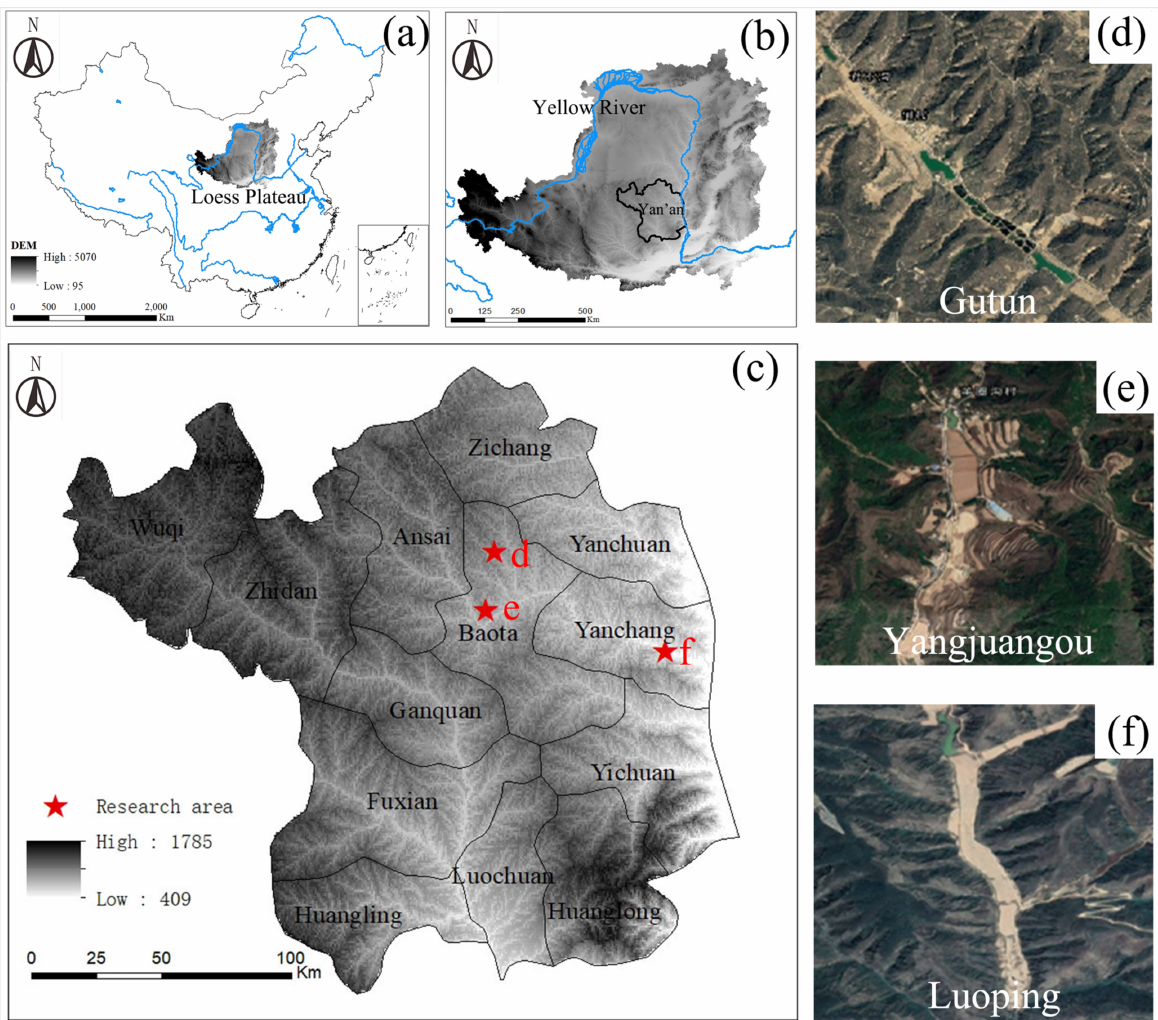
Figure 1. Location of Yan’an City ( a – c ) and the general situation of Gutun, Yangjuangou, and Luoping ( d – f